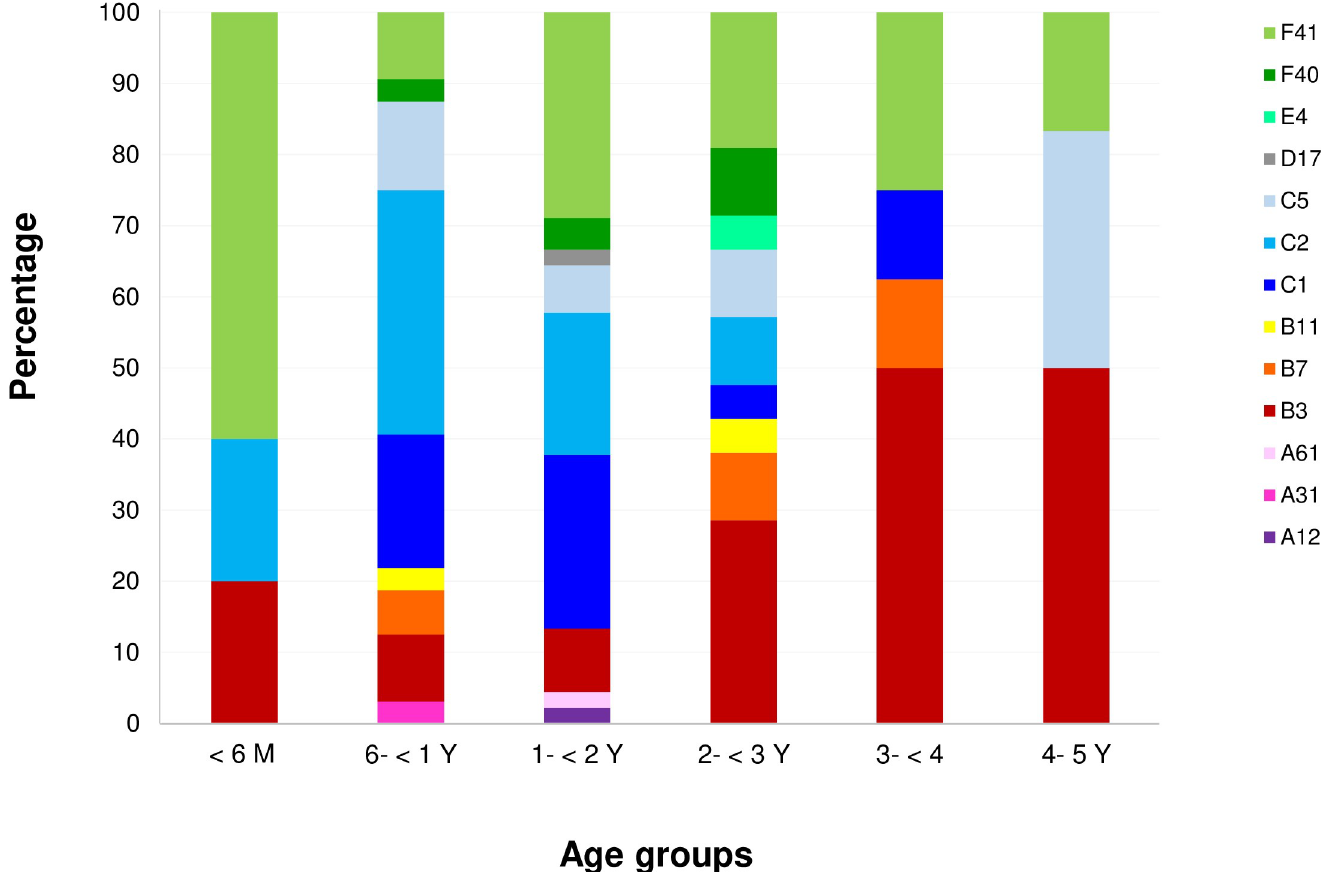
Fig 4. Distribution of human adenovirus genotypes among children of different age